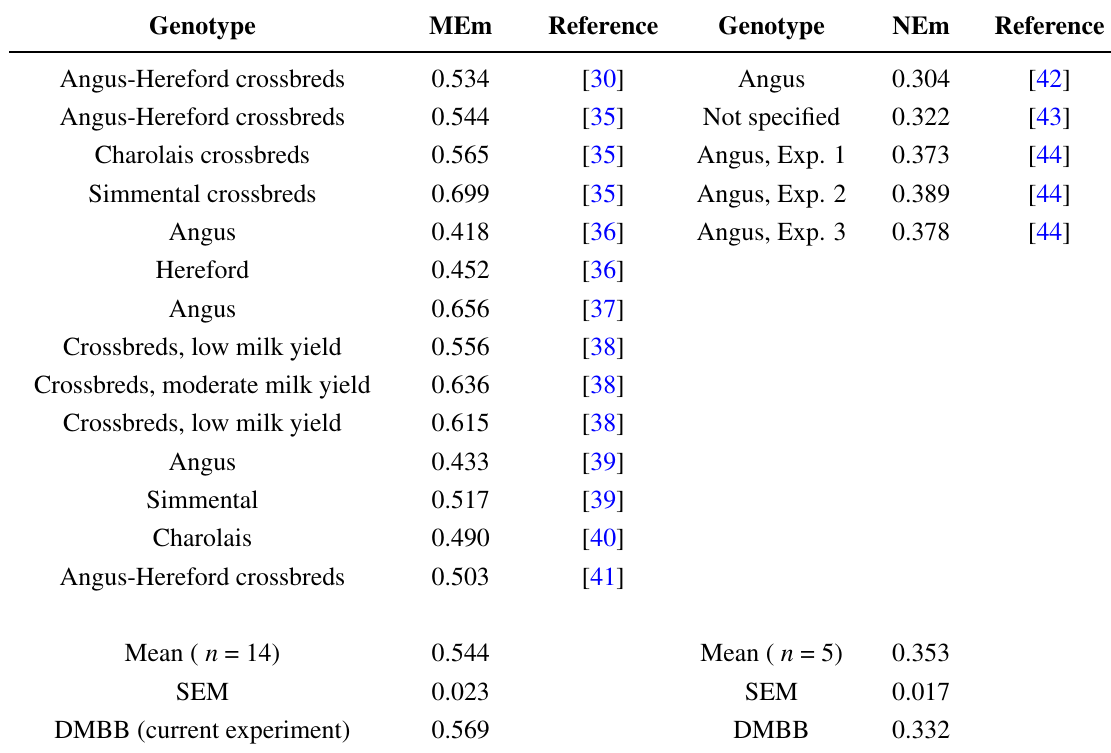
Table 4. Comparison of metabolizable (MEm) or net energy (NEm) requirements (MJ/kg BW 0 . 75 ) for maintenance of beef cows of different